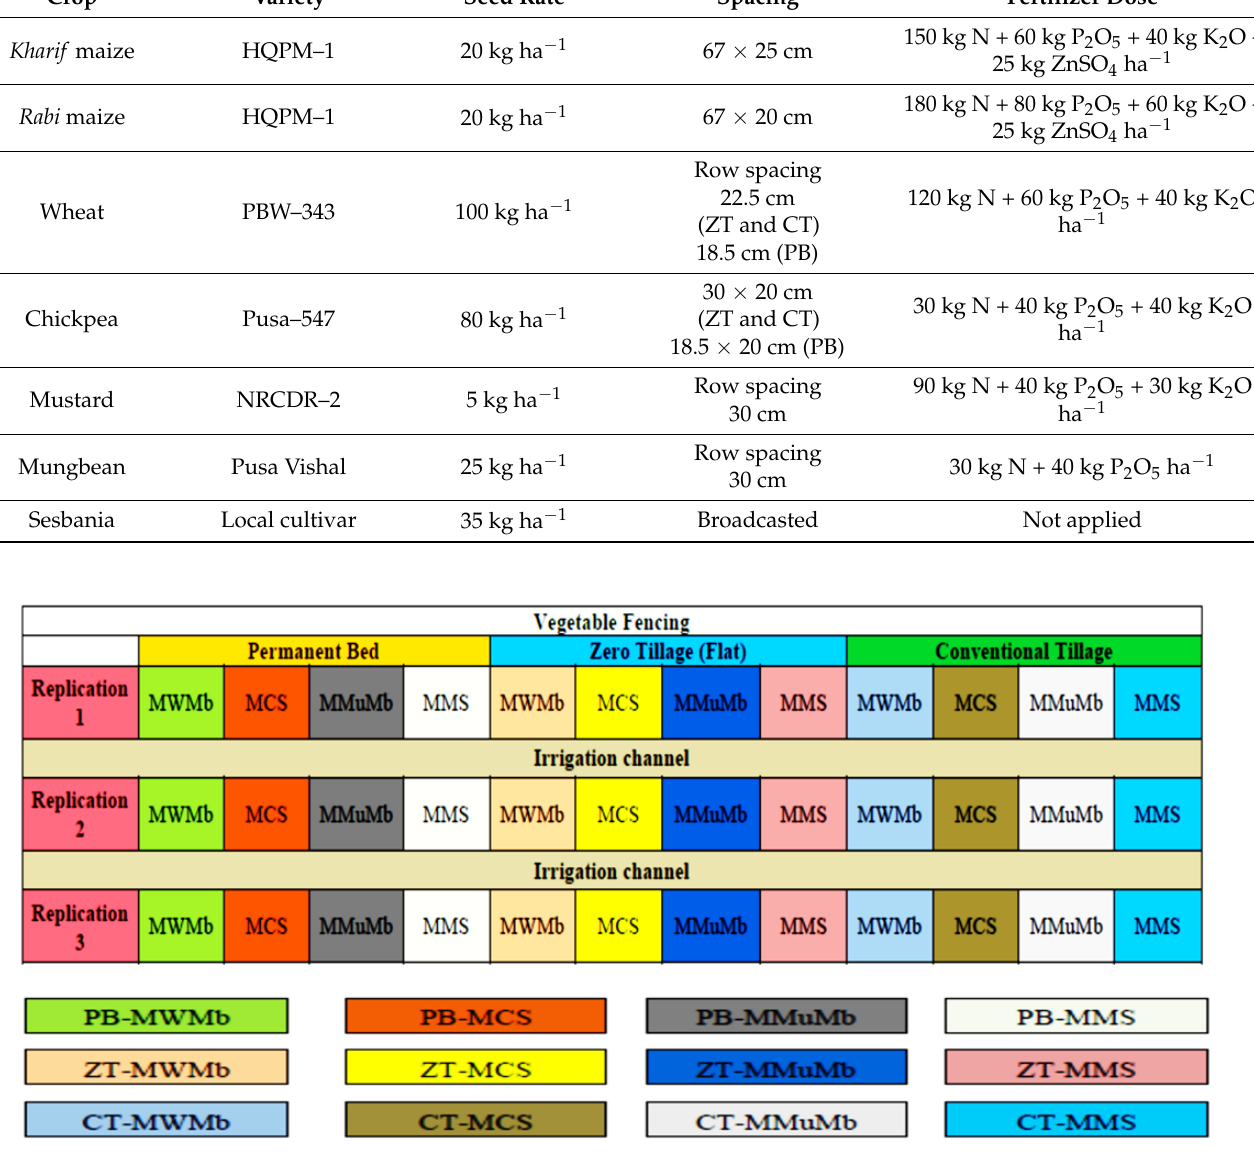
Figure 1. Layout of the experimental field.